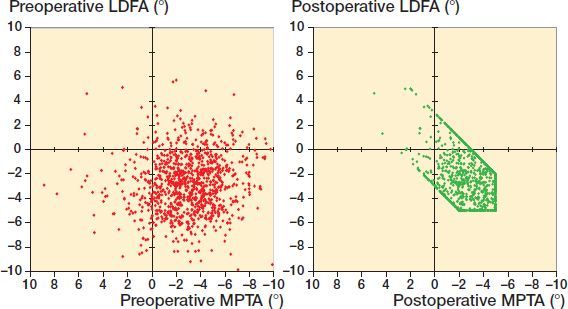
LDFA and MPTA comparing preoperative and postoperative distributions.